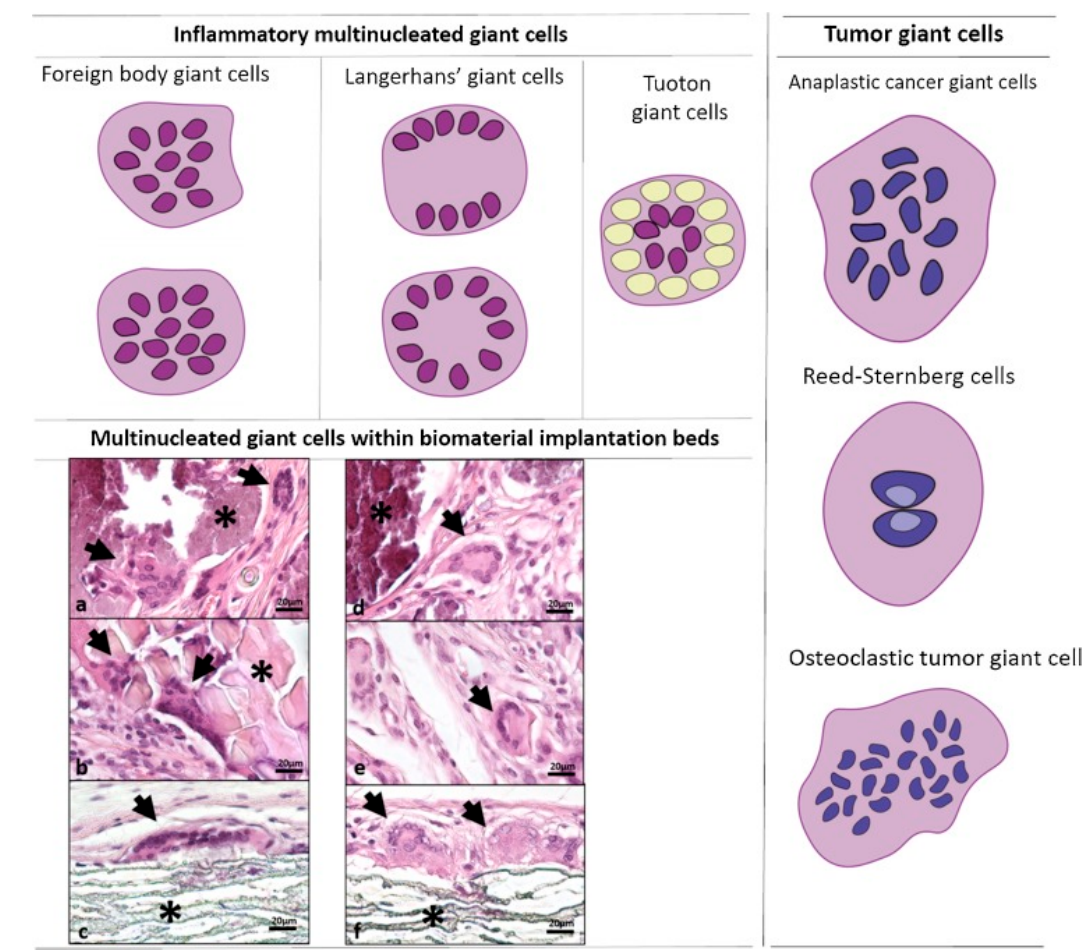
Figure 1. Schematic representation of the histopathological features of multinucleated giant cell subtypes. Examples of histological giant cells micrographs are provided, representing the cellular response within the subcutaneous implantation sites of biomaterials. ( a ) Foreign body giant cells with heterogeneously distributed nuclei (black arrows) within the implantation site of a bone replacement material (*) on day 15. ( b ) Foreign body giant cells with heterogeneously distributed nuclei (black arrows) within the implantation site of silk fibroin (*) on day 60. ( c ) Foreign body giant cells with heterogeneously distributed nuclei (black arrows) within the implantation bed of expanded polytetrafluoroethylene (*) on day 60. ( d ) Langerhans’-like giant cells with peripherally oriented nuclei in a circle (black arrow) within the implantation site of a bone replacement material (*) on day 10. ( e ) Langerhans’-like giant cells with peripherally oriented nuclei (black arrow) within the implantation bed of silk fibroin (*) on day 15. ( f ) Langerhans’-like MNGCs with peripherally oriented nuclei in a circle (black arrow) within the implantation bed of expanded polytetrafluoroethylene (*) on day 30. All histological stains are hematoxylin and eosin with 400 × magnification. Reed–Sternberg cells are found in malignant tumors, such as Hodgkin’s lymphoma, and have two nuclei. In addition, giant cell bone tumors have evenly distributed nuclei within the cytoplasm. The figure is adapted under creative common license from reference